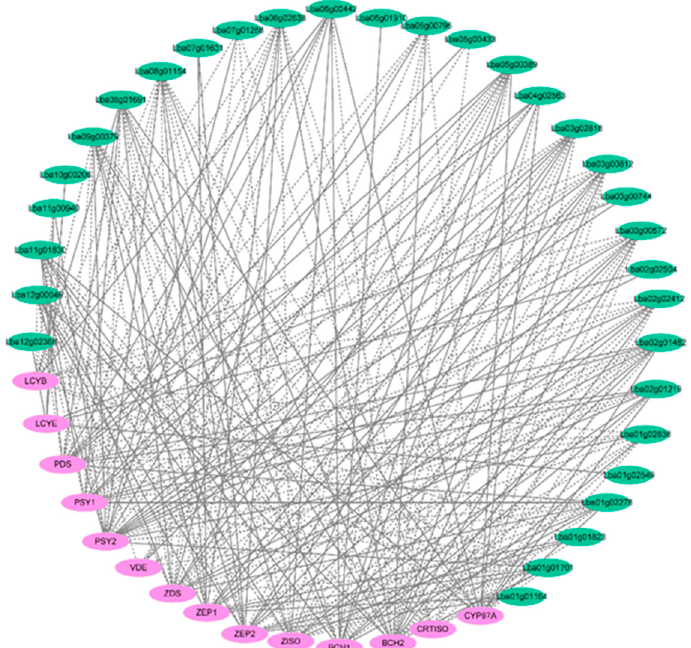
Figure 8. Co-expression networks of LbaR2R3-MYB DEGs and CBGs. Green boxes represent LbaR2R3-MYB DEGs, and purple boxes represent CBGs. The solid lines indicate positive correlations, and the dotted lines indicate negative correlations.